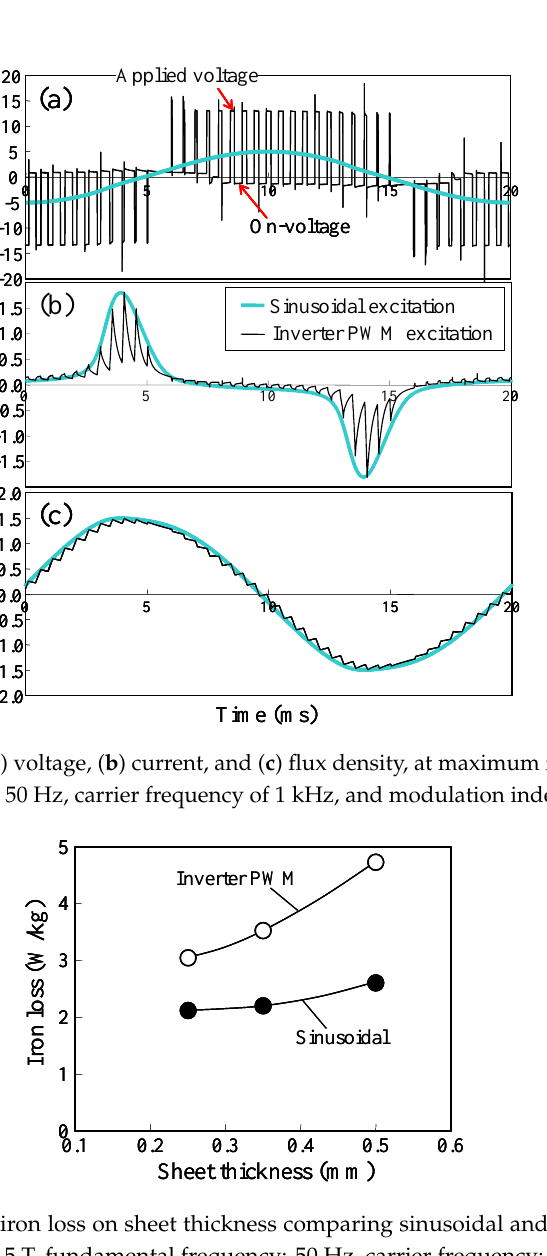
Figure 9 . Ratio of iron loss of different thickness materials with respect to carrier frequency. Measurement conditions are the same as in Figure 8.